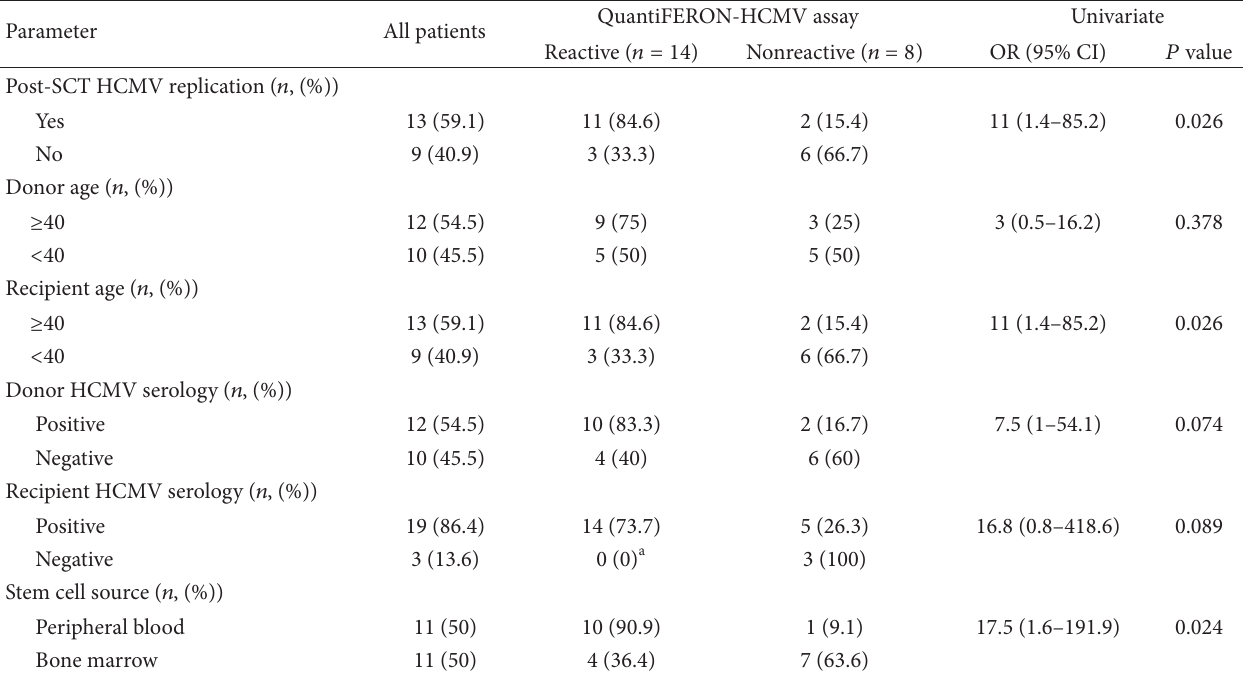
T 3: Univariate analysis of factors associated with “INF-